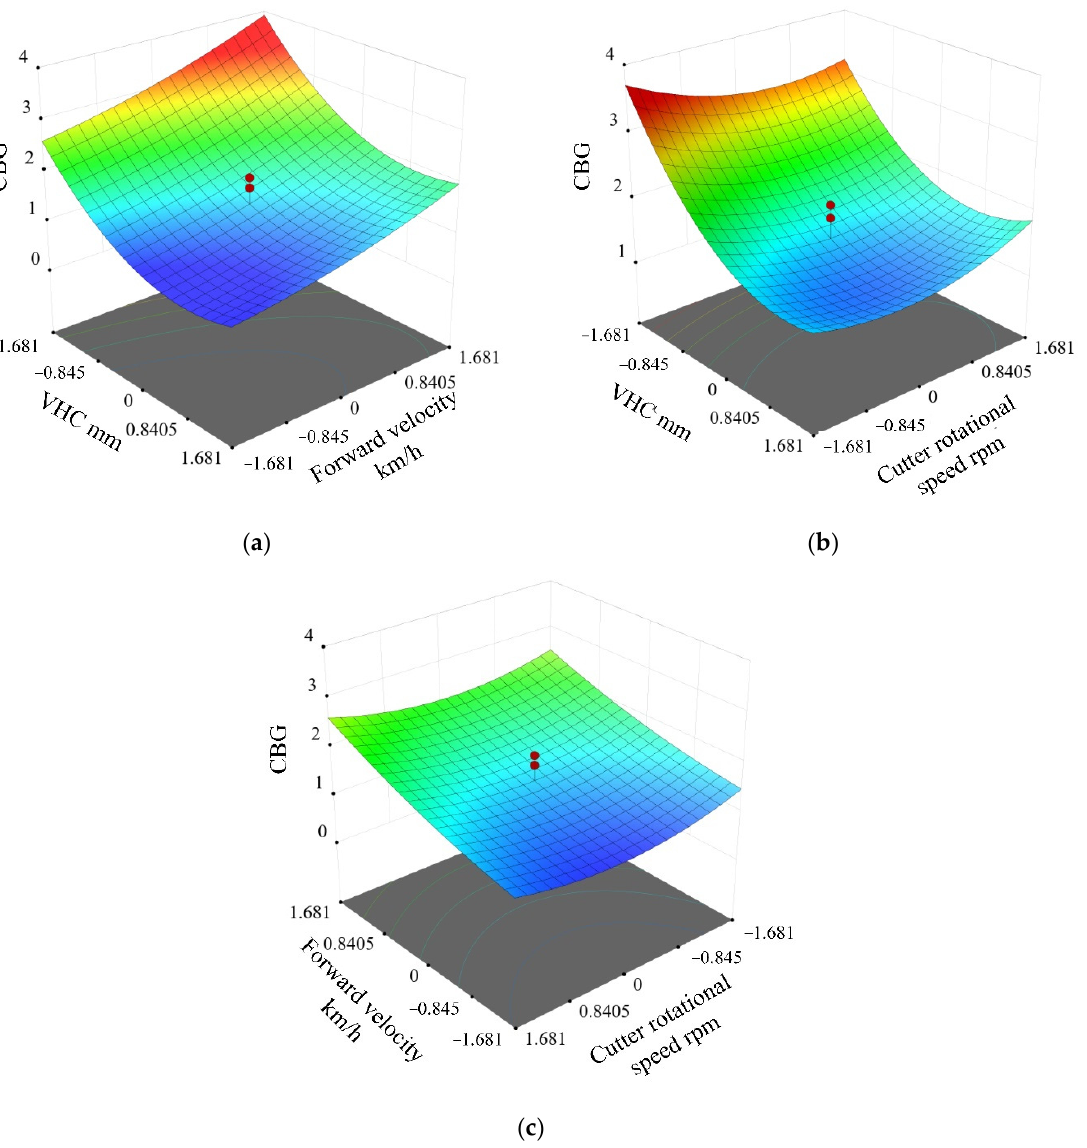
Figure 8. Response surface results for the CBG. ( a ) ( X 1, X 2, 0); ( b ) ( X 1, 0, X 3); ( c ) (0, X 2, X 3).